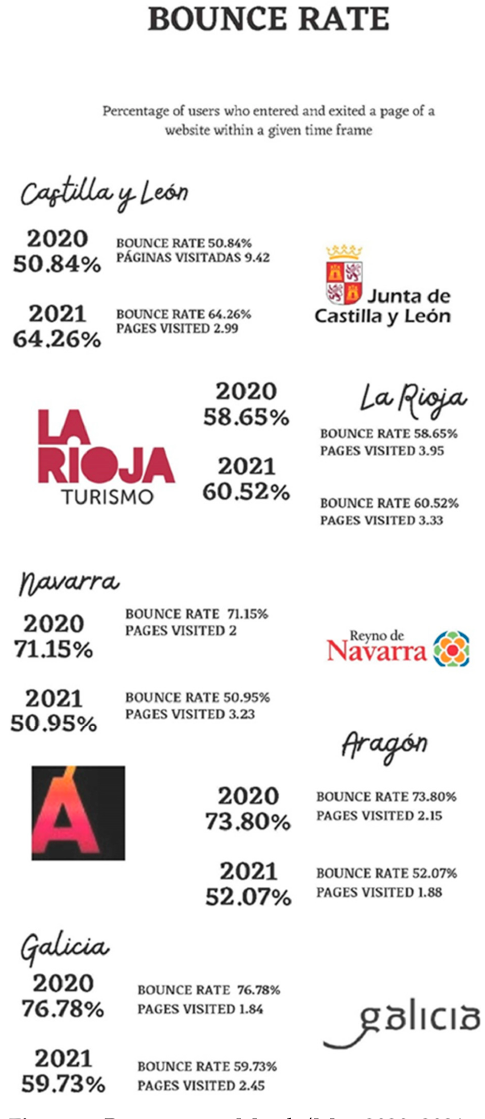
Figure 6. Bounce rates March/May 2020–2021 .